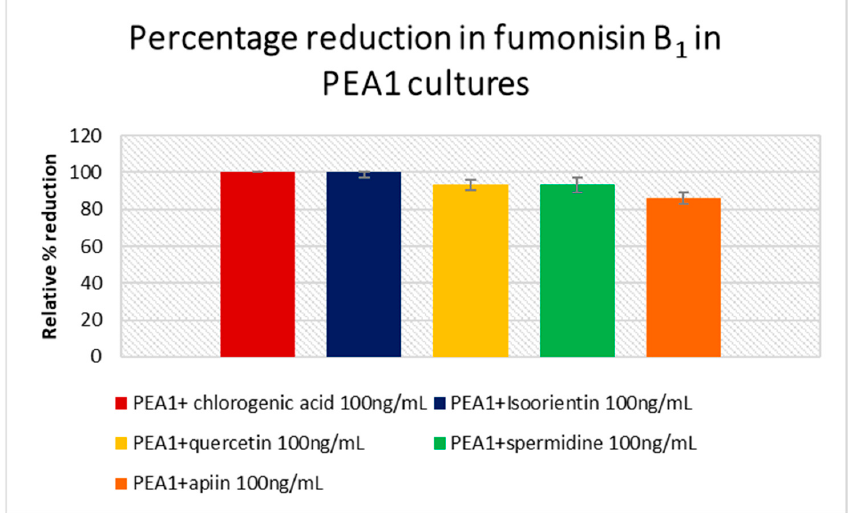
Figure 4. Percentage of fumonisin B 1 reduction with respect to the control in F. proliferatum PEA1 cultures treated with various concentrations of host metabolites. Error bars represent standard error.